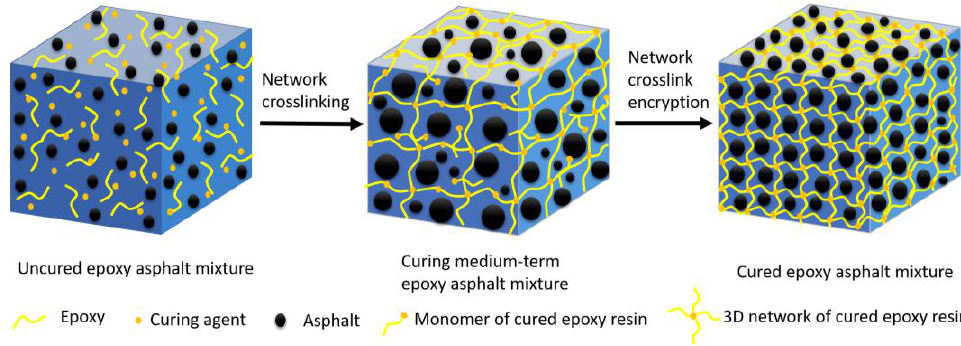
Figure 9. Schematic of the epoxy asphalt curing process.